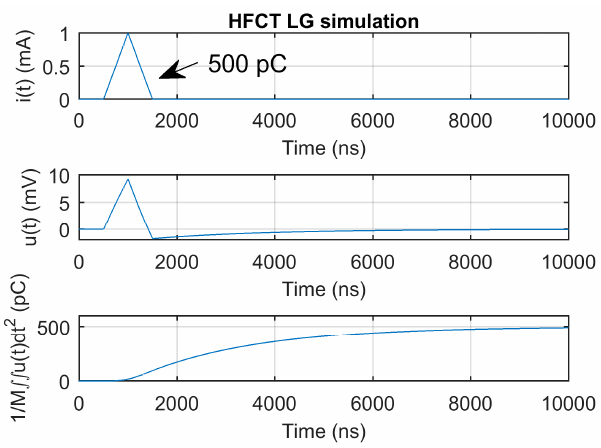
Figure 9. HFCT_LG sensor response and charge estimation of a 500 pC and 1000 ns triangular current pulse.